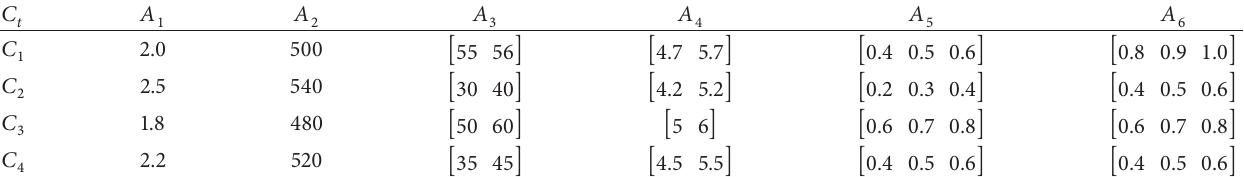
Table 1: Index values of every